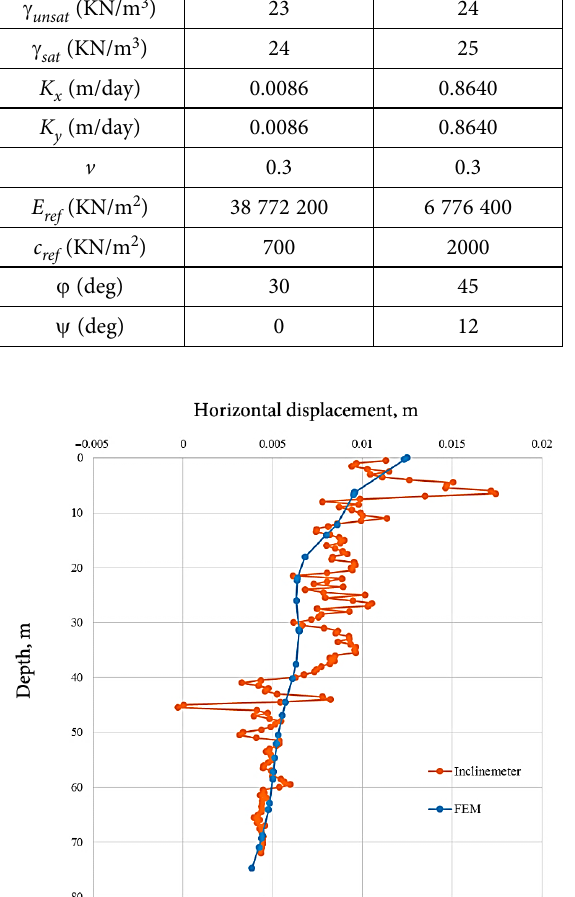
Fig. 10. Evaluation of horizontal displacements of modeling and instrumentations versus depth